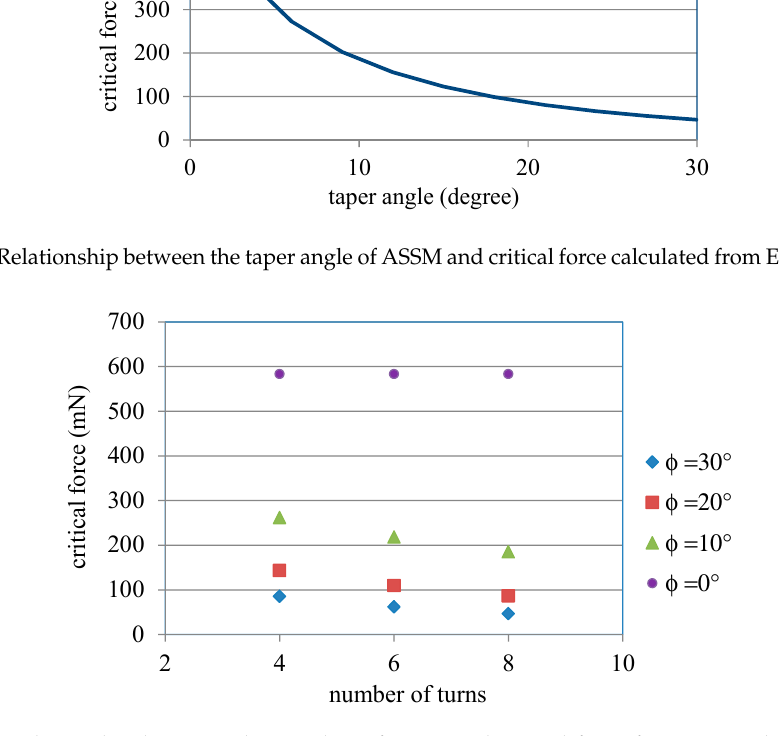
Figure 8. Relationship between the number of turns and critical force for ASSM calculated from Equation (10).